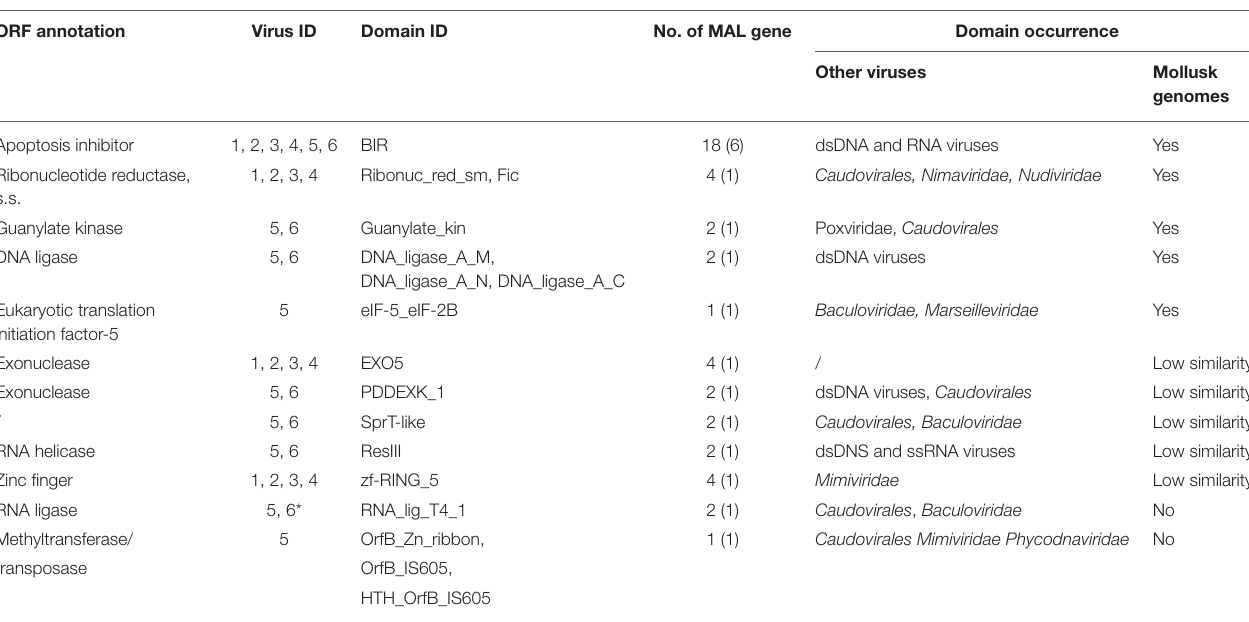
TABLE 3 | Viral ORFs with M alacoherpesviridae -specific protein